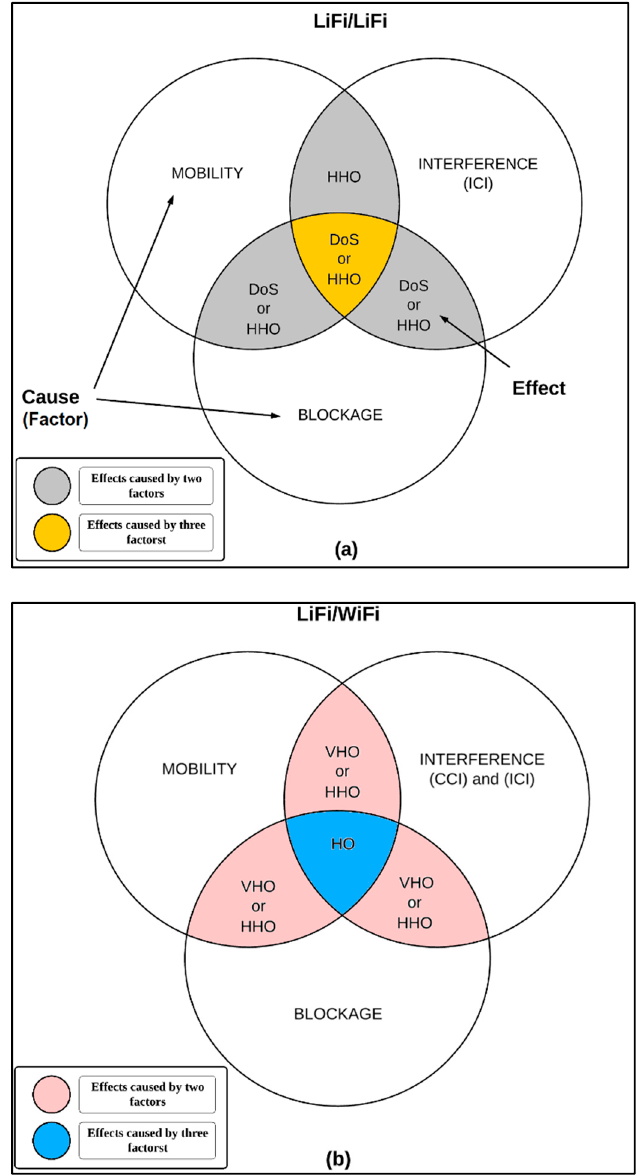
Figure 8. Relationship of issues in LiFi ( a ): LiFi/LiFi/( b ) LiFi/Wi-Fi.